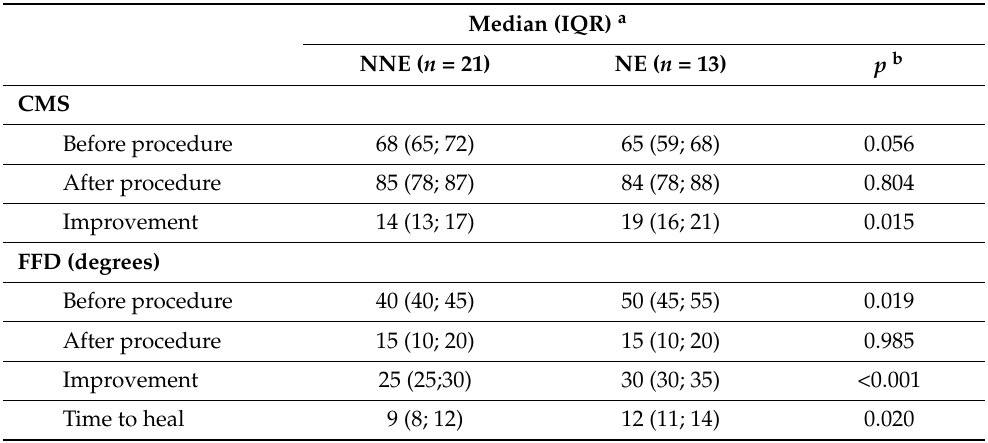
Table 3. Comparison of group characteristics and treatment outcomes of patients in whom the intramedullary nail was (NE group) or was not (NNE group) extracted during the arthrolysis (please note that proximal locking screws were removed and arthrolysis performed in all